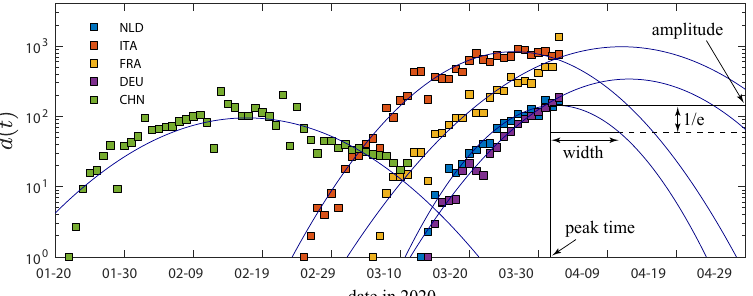
Figure 2. Logarithmic reported number of daily fatalities (squares) and the quadratic fits of number of daily fatalities (lines) over time for some countries. The plots demonstrate the quadratic nature of the logarithmic fatalities per day during times for which data already exists. The solid curves are GM predictions, according to Equation (A1). The fitted model (solid lines) can be used to extrapolate existing data to future times, to predict for example the time point of the maximum. This is what we use in the following to generate predictions based on the fit. The meaning of the GM parameters is highlighted in the inset. Raw data taken from Ref. [25]. These predictions as of April 2 are compared with latest data on our Supplementary website